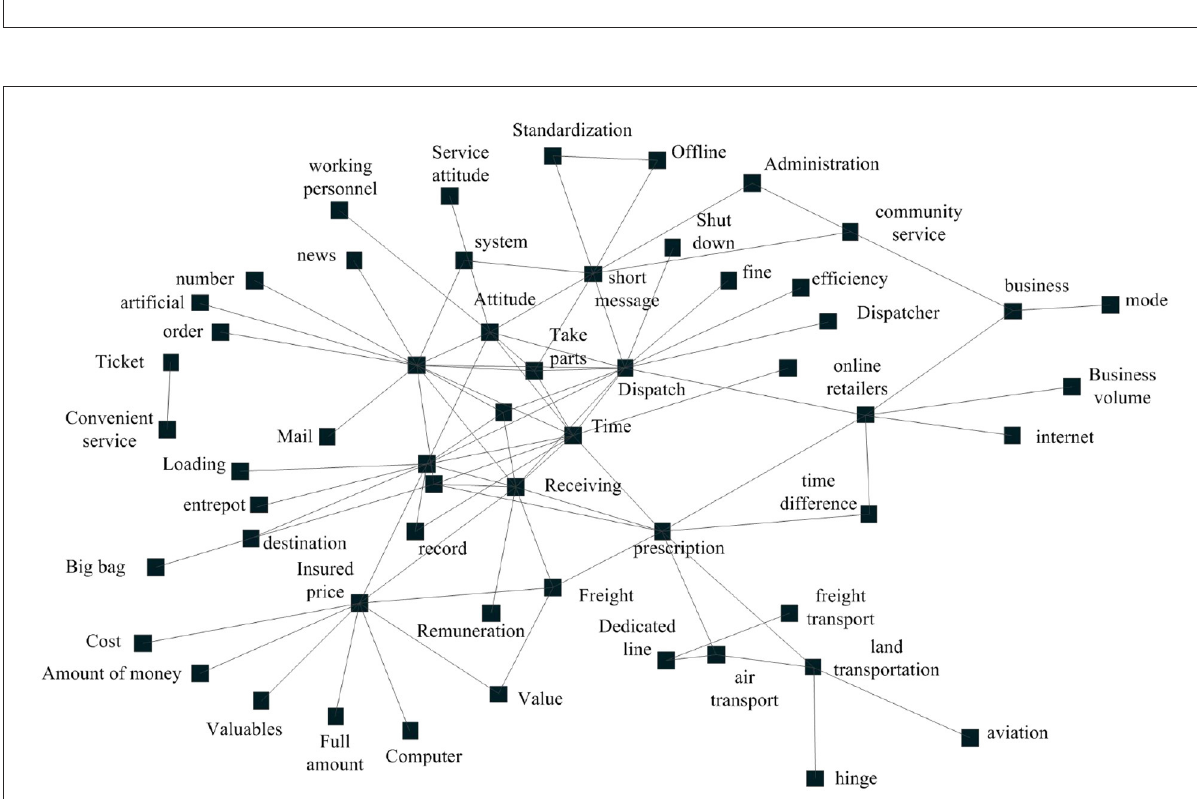
FIGURE4 Semantic network diagram of defects in express